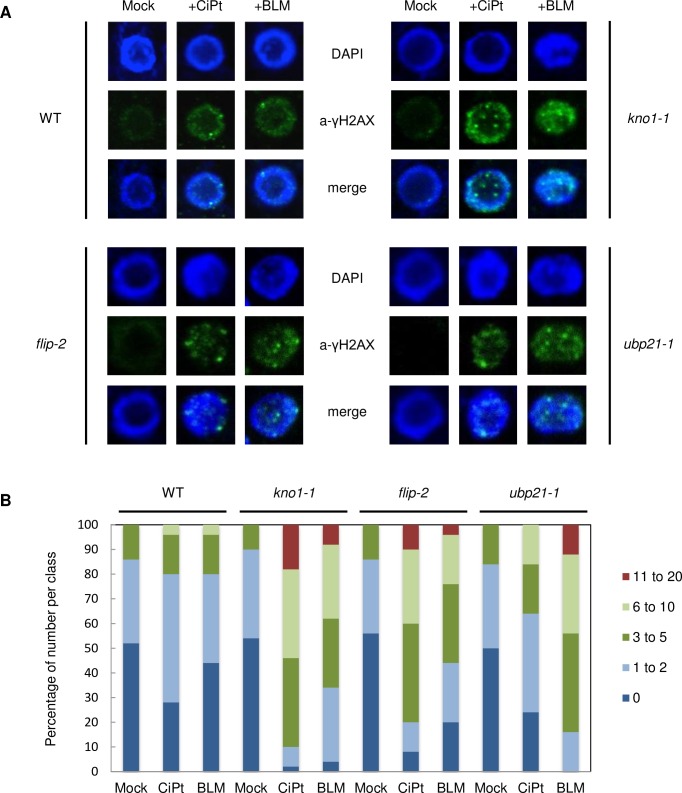
DNA damage analysis in the wildtype versus kno1-1, flip-2 and ubp21-1 mutants.(A) Root nuclei incubated with an anti-γH2AX antibody after 3 hr treatment of seedlings with cisplatin and bleomycin in comparison with mock treated samples. (B) Quantification of γH2AX foci, 50 nuclei were counted per line.